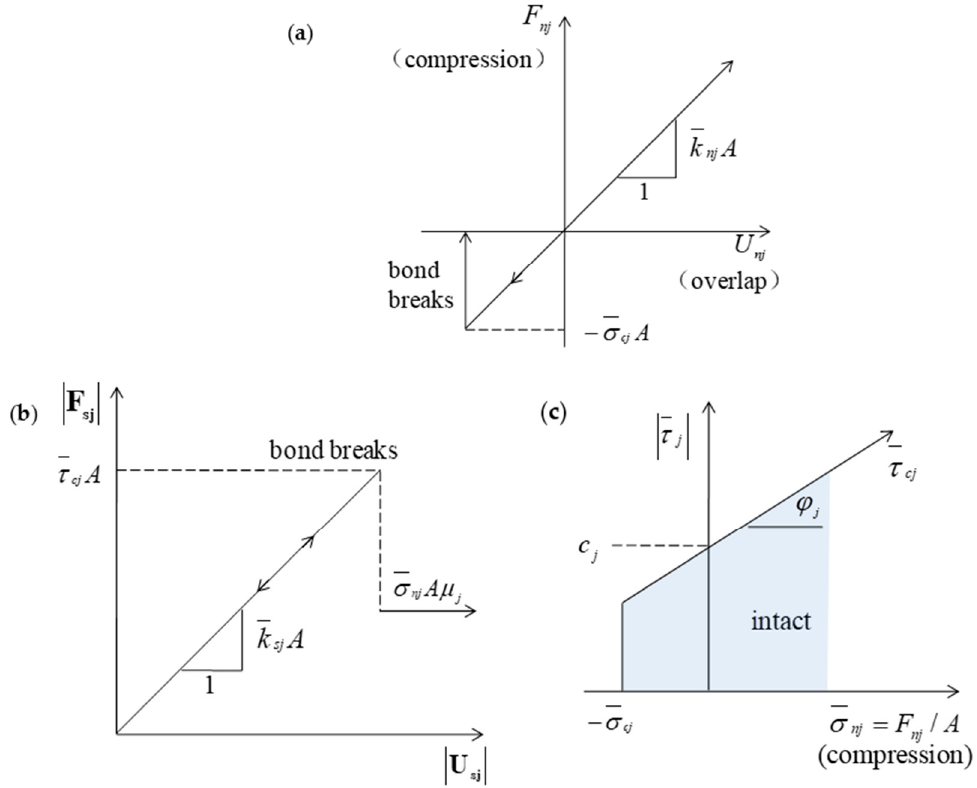
Figure 5. Constitutive law for a bonded smooth joint model: ( a ) normal force, F nj , versus normal displacement, U nj ; ( b ) shear force, F sj , versus shear displacement, U sj ; and ( c ) strength